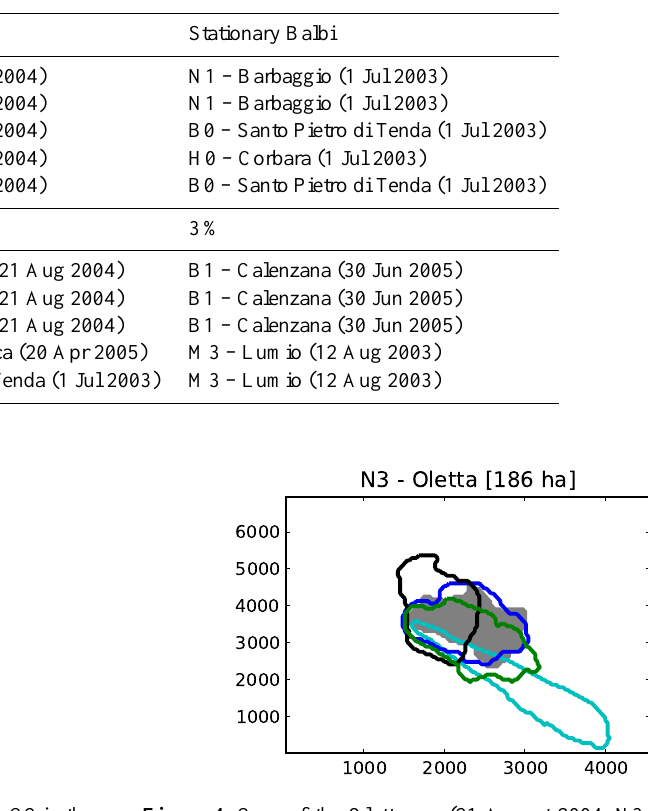
In figure 5, we plotted the case for which the Balbi model and Rothermel model at- tained their best shape agreement. The visual agreement with the observed contour does not seem as good as in the previous fire case. Hence the dynamics of the fire must have significantly contributed to the shape agreement. This suggests that taking into account the front dynamics in the evaluation can cast different light on a model. 5